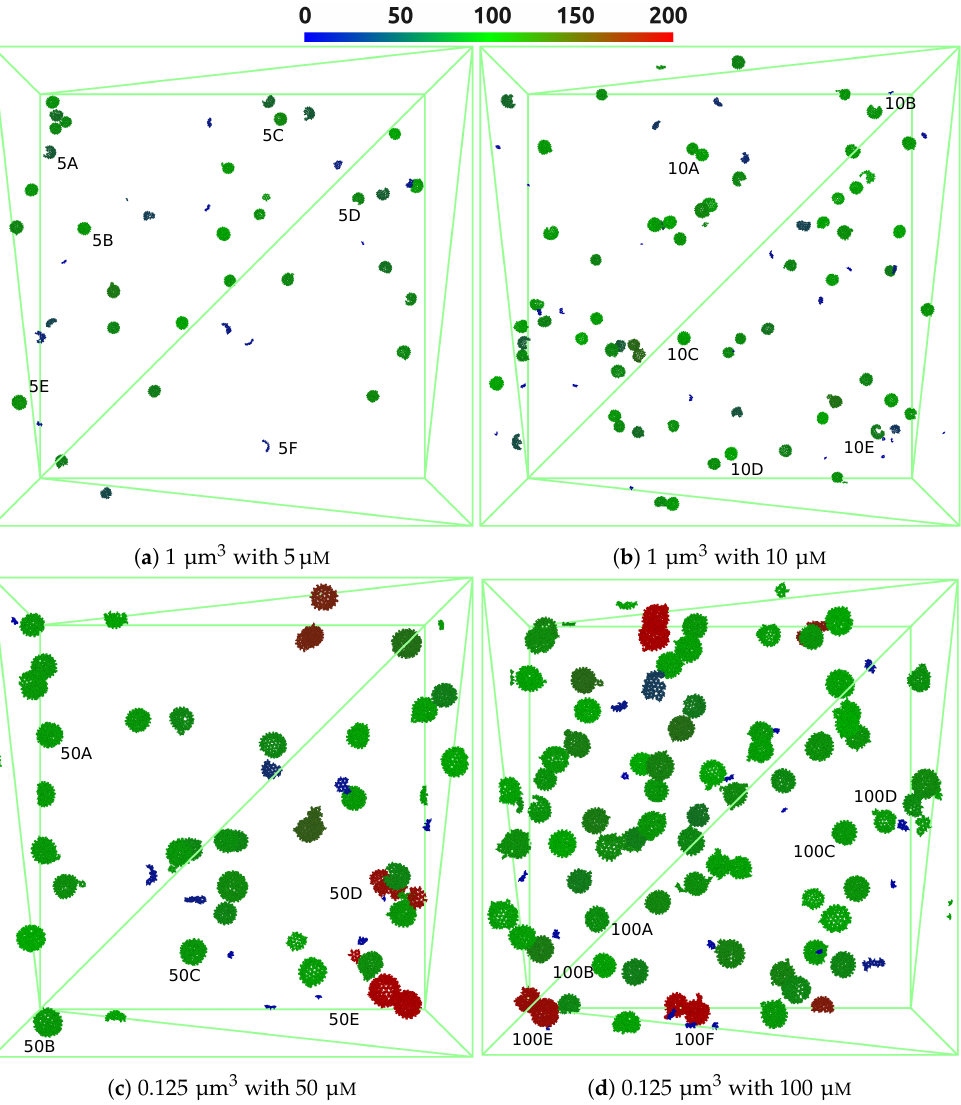
Figure 12. Visualizations of VLP self-assembly using simulation protocol SP3. Colors indicate structure size by number of dimers ( N SAS ) and backbone carbon atoms are visualized. Structure 50E exceeds scale with 221 and red structure at top left of ( d ) contains 233